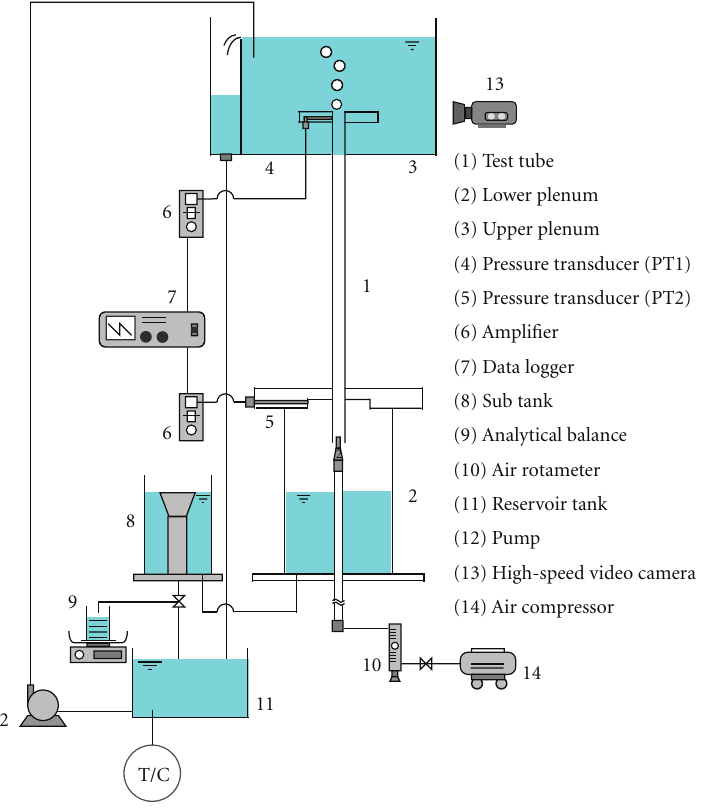
Figure 1: Schematic diagram of experimental apparatus.